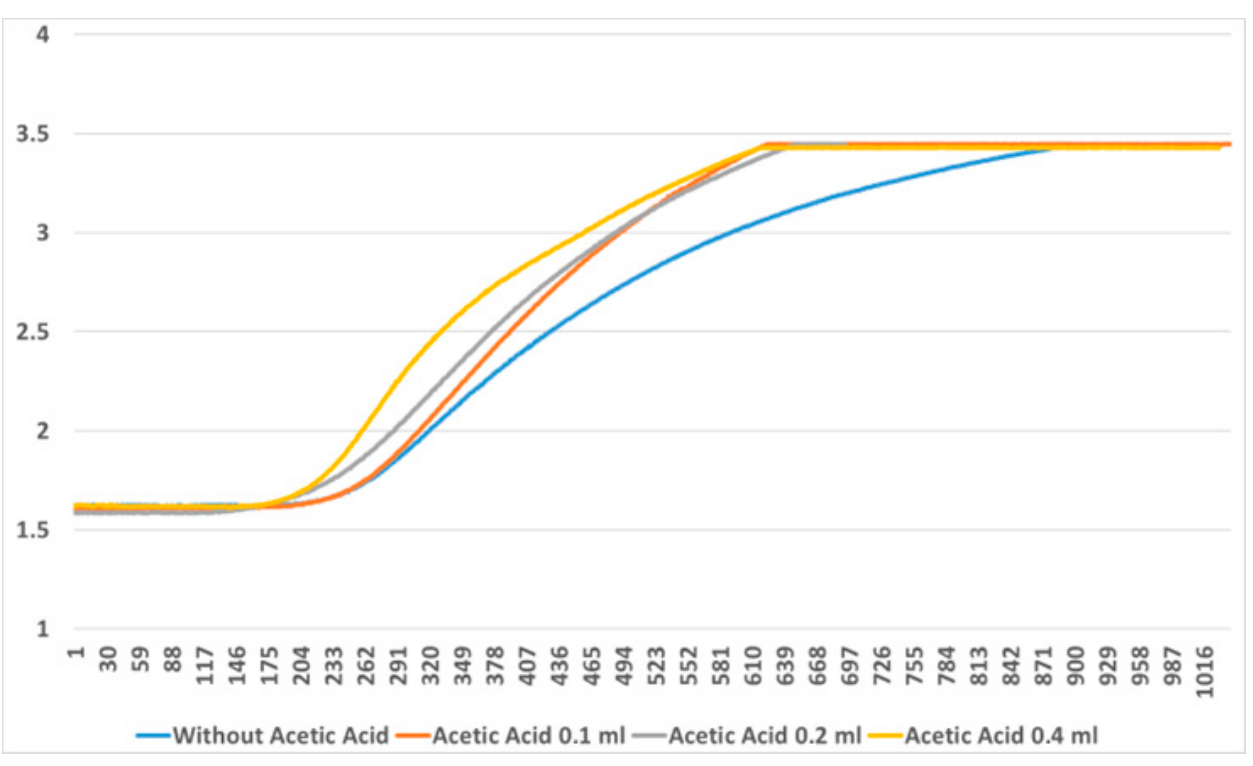
Figure 5. Wine without acetic acid and with 3 different acetic acid solutions (1, 2, and 4%). The sampling time is measured in tenths of a seconds.